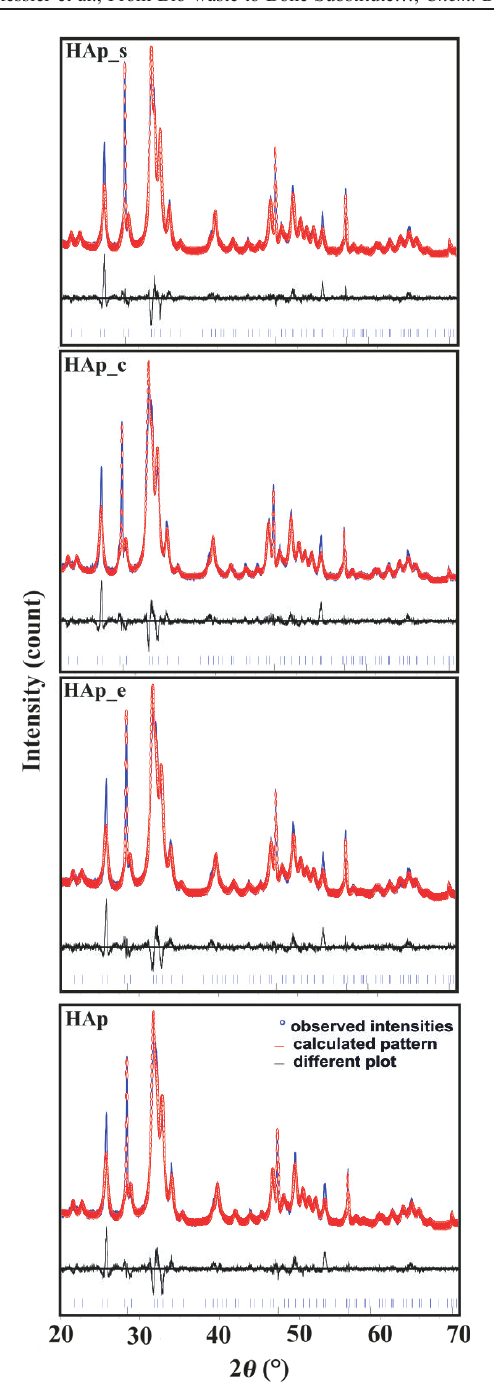
Fig. 3 – Rietveld analysis pattern of powder diffraction data for as-prepared CaP powders obtained from different biogenic sources. The open circles are experimental data and the solid lines are calculated intensities. The difference between the ex- perimental and calculated intensities is plotted below the pro- file (R < 11 %; R < 3 %). Bragg positions of hydroxyapatite wp exp and silicon (standard) are marked below each pattern.